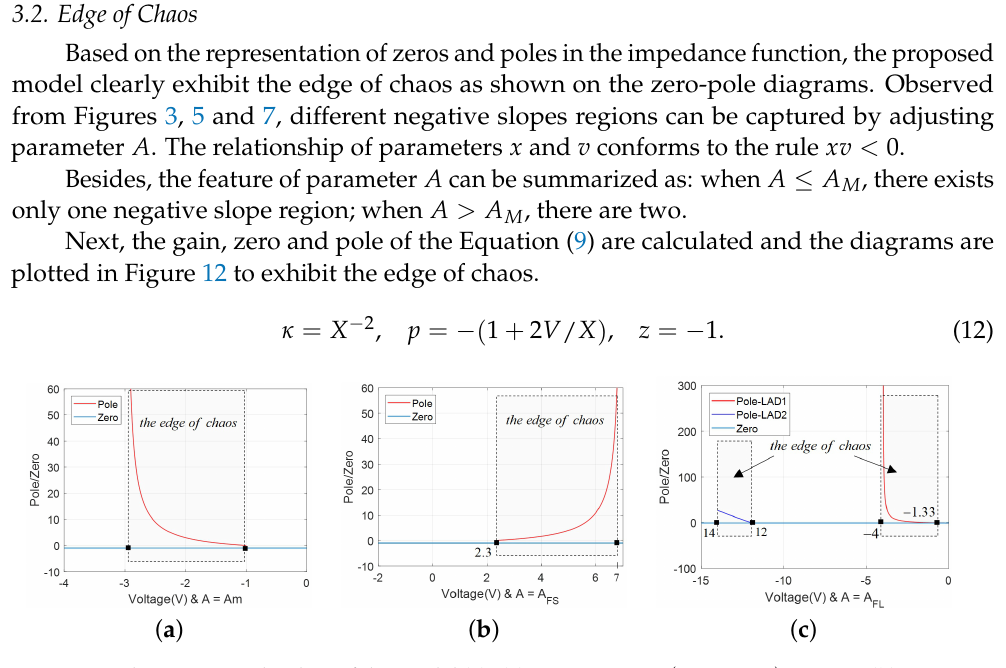
Figure 12. The zeros z and pole p of the model (1): ( a ) A = A M , v ∈ ( − 3, − 0.99 ) in LAD; ( b ) A = A FS , v ∈ ( 2.3,7.0 ) in LAD; ( c ) A = A FL , v 1 ∈ ( − 4.0, − 1.33 ) in LAD1 and v 2 ∈ ( − 14.0, − 12.0 ) in